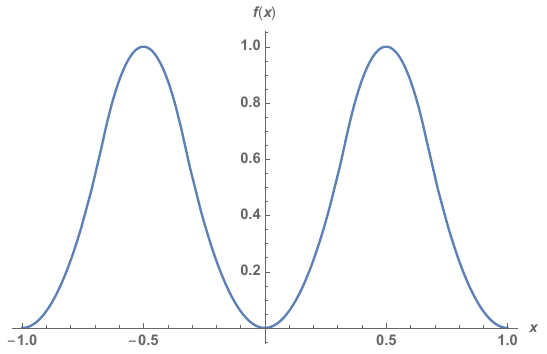
Figure 1 . The function f , determining the leading behavior of the e(cid:11)ective